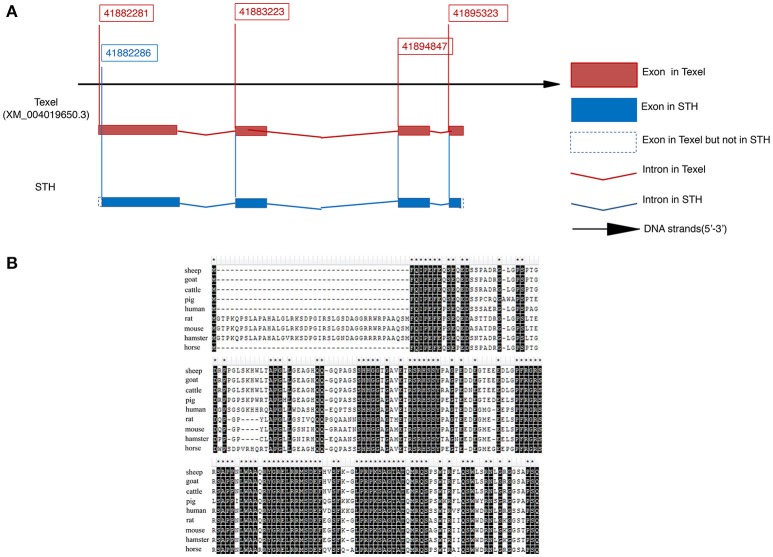
Molecular cloning and characterization of ovine BAD gene in Small Tail Han sheep (A,B). (A) mRNA sequence of BAD gene. (B) protein sequence of BAD gene. Multiple alignment of sheep BAD protein sequence with orthologs from other species (sheep, goat, cattle, pig, human, rat, mouse, hamster and horse).